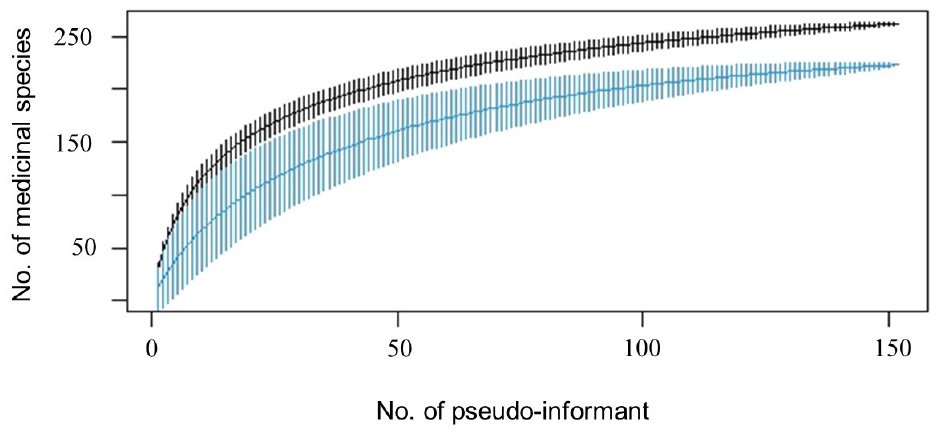
Figure 2. Accumulation curves for medicinal legume species in Thailand, plotted by increasing numbers of primary data sources (pseudo-informants). The black line shows the accumulation of all medicinal legume species in this study, whereas the blue line shows the accumulation when singletons were excluded.